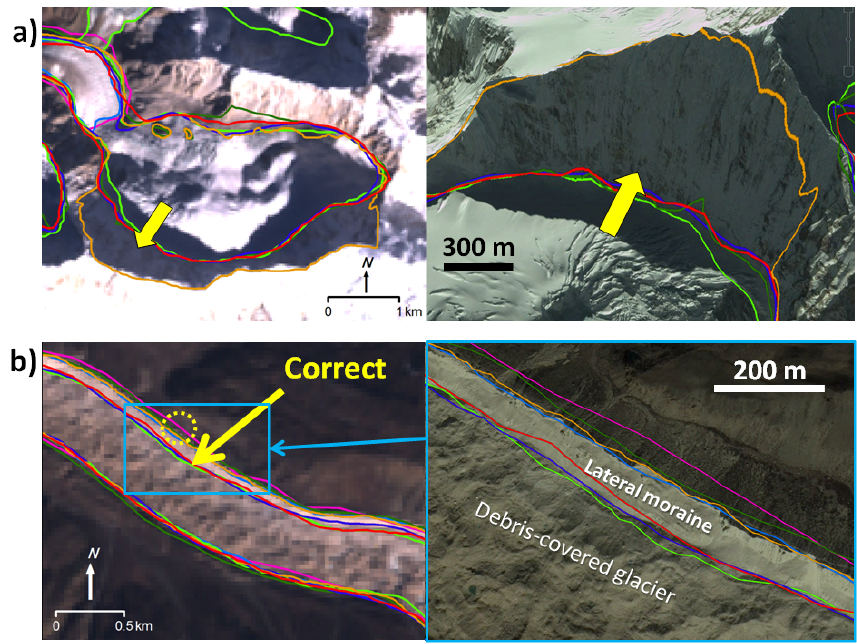
Figure 10. Examples of delineation tests, in which coloured lines represent glacier outlines delineated by different operators. Both back- ground images (left panels) are true-colour composites of the Landsat ETM + scenes. Right-hand panels in both (a) and (b) are Google Earth TM screenshots, © 2014 DigitalGlobe.